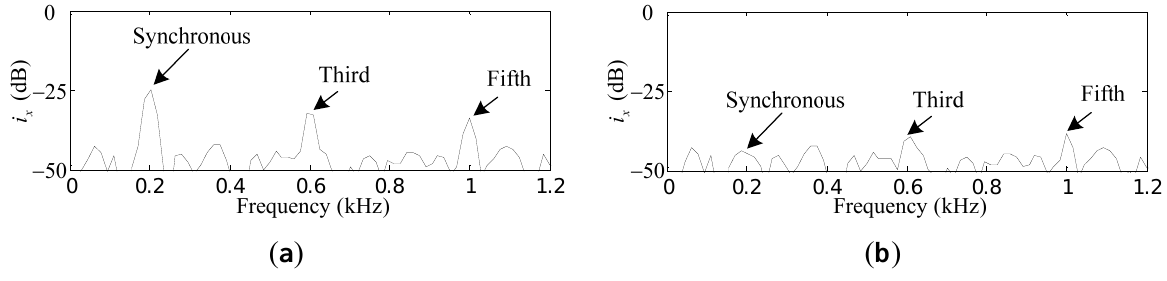
Figure 15. Simulation results of i x : ( a ) before harmonic current suppression; ( b ) after harmonic current suppression.